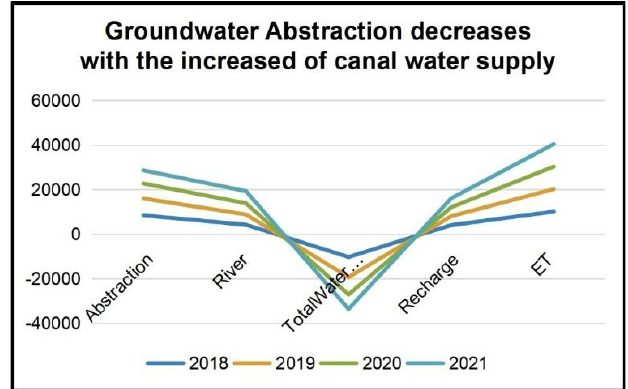
Figure 8: increased the canal water supply with Decreased the GW abstraction